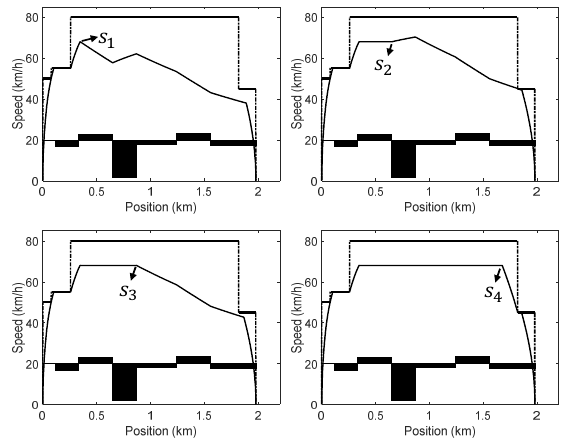
Figure 4. Driving strategies for the train, respectively, coasting from s 1 , s 2 , and s 3 , s 4 .